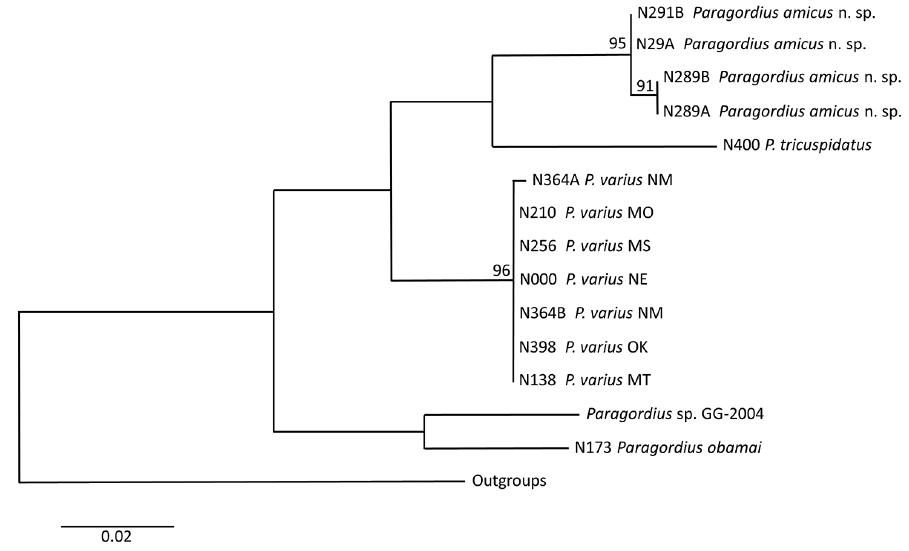
Figure 6 . Relationships inferred by maximum likelihood. Tree is unrooted, and drawn to scale indicating number of substitutions per site. Bootstrap values above 0.90 are